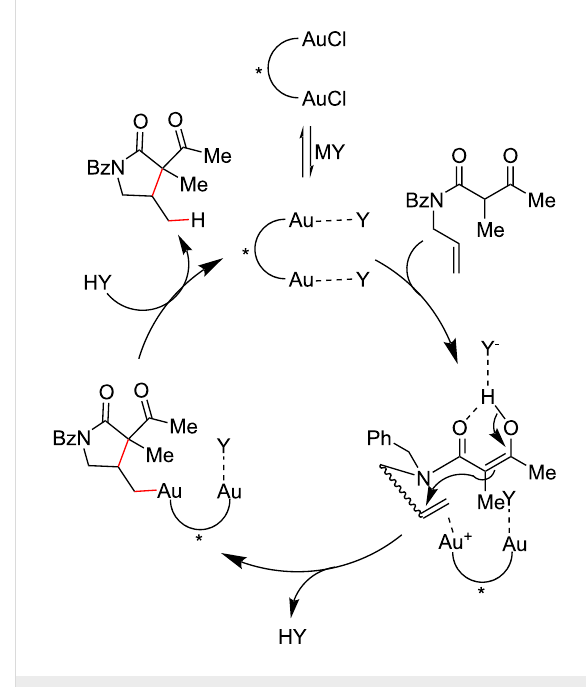
Scheme 10: Proposed mechanism for the chiral gold(I) complex promotion of the intermolecular olefin hydroalkylation of an N -alkenyl β -ketoamide (Gandon (2014)